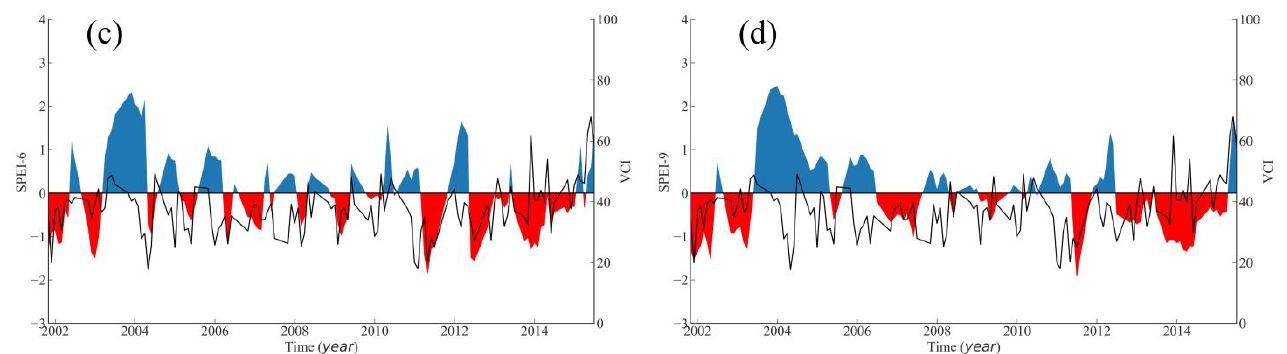
Figure 8. VCI and SPEI during winter wheat growth in Henan Province from 2001 to 2015 at ( a ) 1, ( b ) 3, ( c ) 6, and ( d ) 9 months.